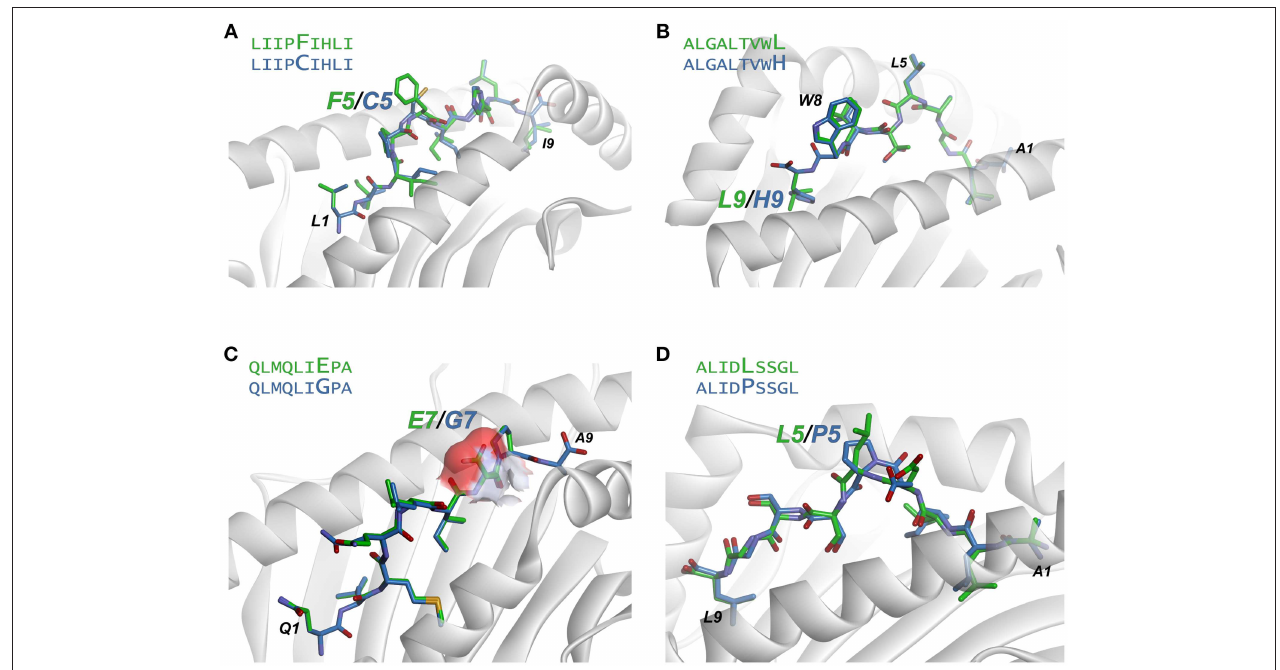
FIGURE 6 | Examination of modeled structures of select neoantigens and their wild-type counterparts. (A) The neoantigen LIIPFIHLI substitutes a phenylalanine for a cysteine at position 5. The position 5 side chain is predicted to extend from the top of a bulge in the peptide, and the mutation results in an increase in exposed hydrophobic surface of 90 Å 2 . (B) The neoantigen ALGALTVWL substitutes a leucine for a histidine at position 9, “fixing” the second primary anchor residue and improving peptide binding to HLA-A2. The leucine at position 5 and tryptophan at position 8 are predicted to extend up from the peptide backbone to form interactions with T cell receptors. (C) The neoantigen QLMQLIEPA substitutes a glutamate for a glycine at position 7. The glutamate 7 side chain in the mutant peptide is predicted to be fully exposed, increasing exposed charged surface area as indicated by the surface area representation for the position 7 side chain. (D) The neoantigen ALIDLSSGL replaces a proline with a leucine at position 5 of the peptide. No conformational consequences are predicted for the